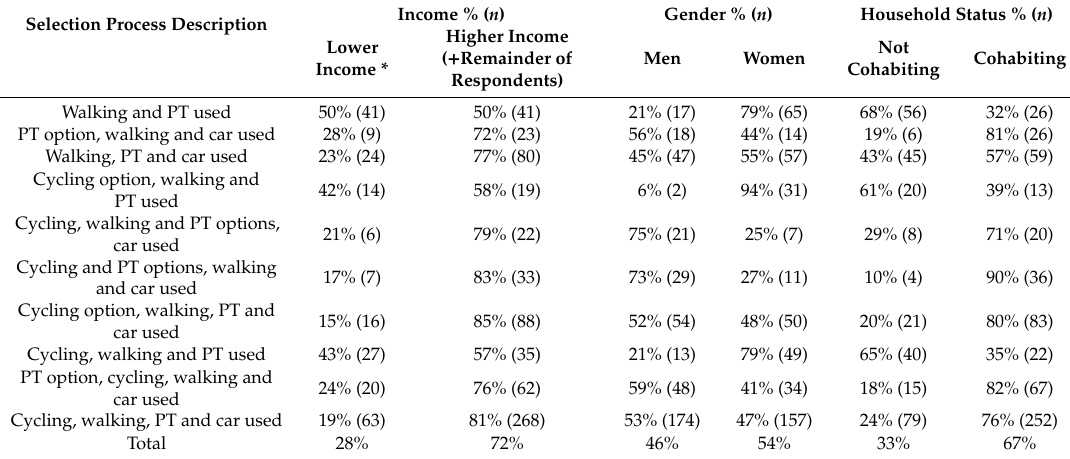
Table 2. Socio-demographic di ff erences in modal choice